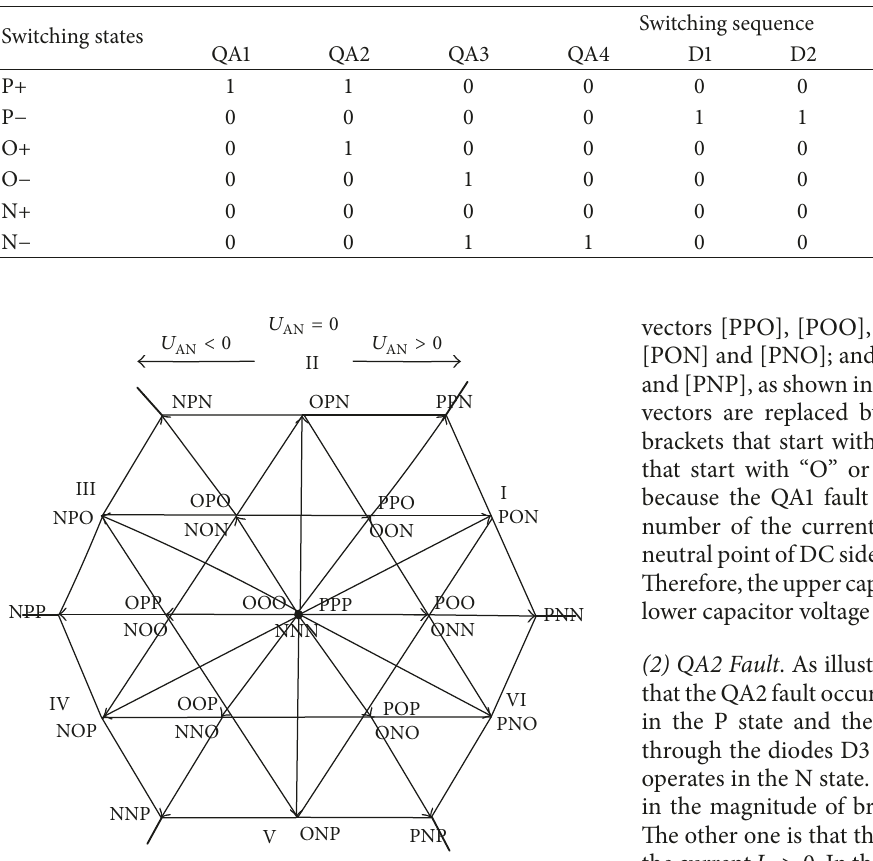
Figure 2: Voltage vector distribution of NPC three-level